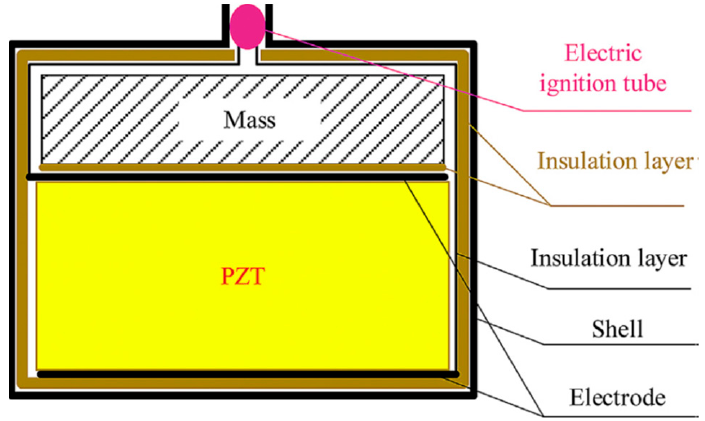
Figure 2. Structure of typical self-powered overload ignition device. Doctors use piezoelectric ceramic probes [61], such as that shown in Figure 3, to examine parts of the human body. To this end ultrasonic waves are emitted and sent to the tissue of the human body to generate an echo. The echo is detected and displayed on a fluorescent screen, so that doctors can understand the internal condition of the human body.